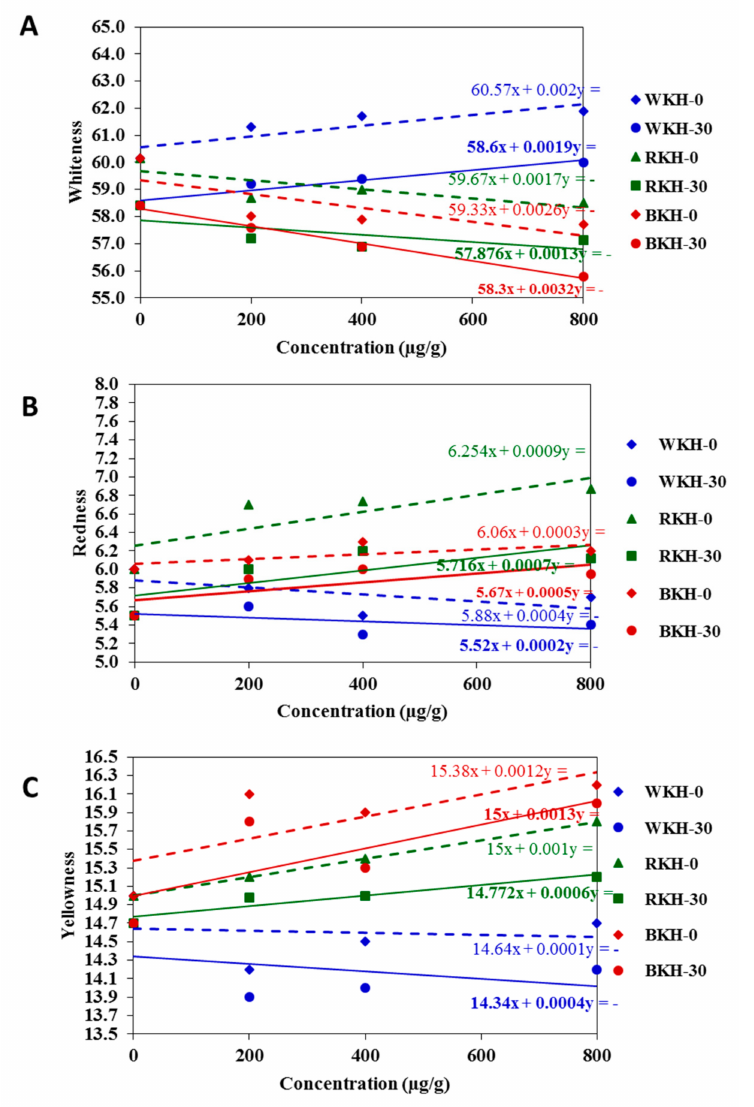
Figure 5. The changes in color parameters ( A ) Whiteness values, ( B ) Redness values, ( C ) yellowness values of supplemented meat with WKH, RKH, and BKH with increasing concentrations or storage period expressed by trendline regression curves for results